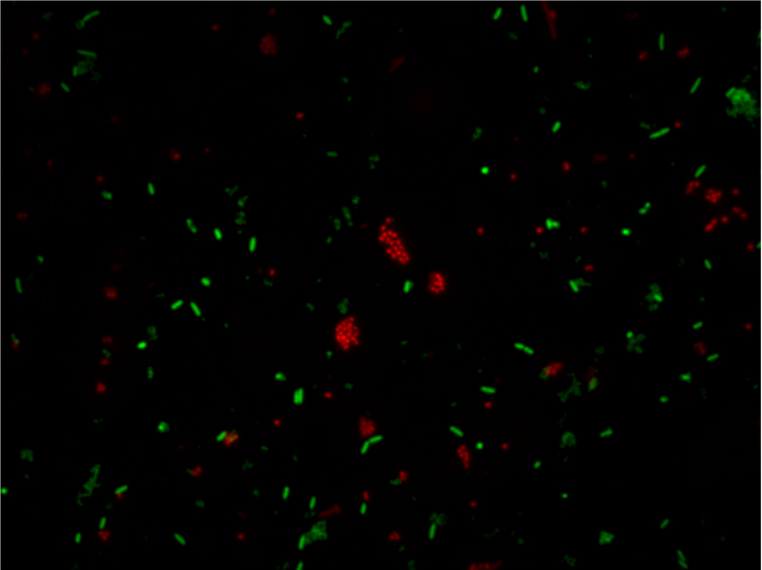
Figure 5. Planktonic state of Pseudomonas fluorescens stained with LIVE/DEAD (SYTO 9 and propid- ium iodine) after treatment with Sodium hypochlorite (350 ppm) for 15 min. Viable bacteria (green) and damaged bacteria (red). Magnification ×100.